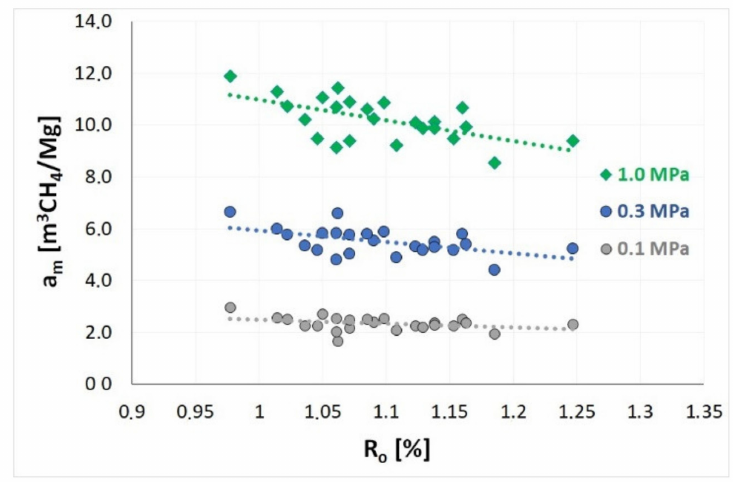
Figure 5. The influence of coalification degree on the sorption capacity ( a ) of coal under the given methane pressure.